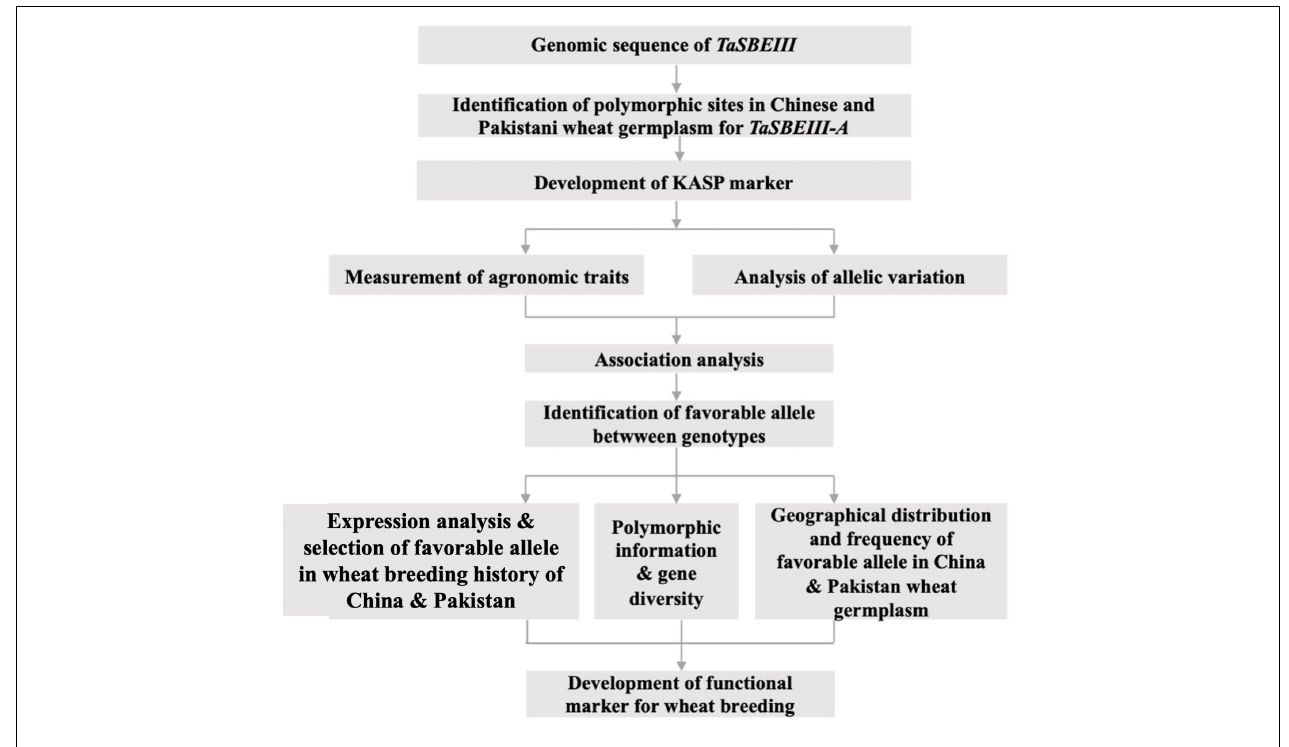
FIGURE 1 | The schematic display of research